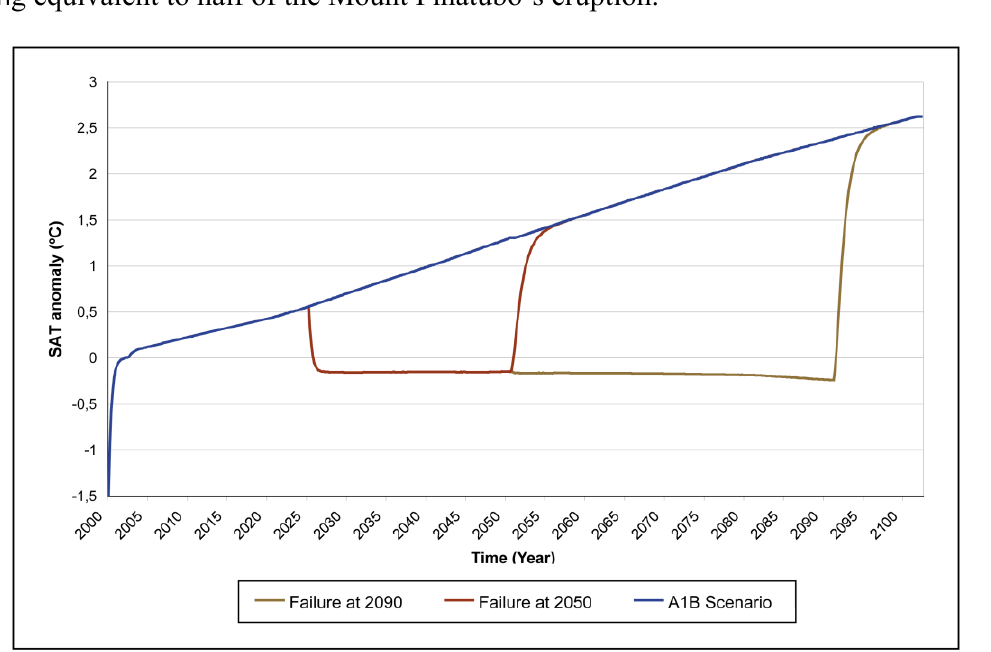
Figure 4. SAT response to geoengineering failures at 2050 and 2090 with a constant loading equivalent to half of the Mount Pinatubo‘s eruption.